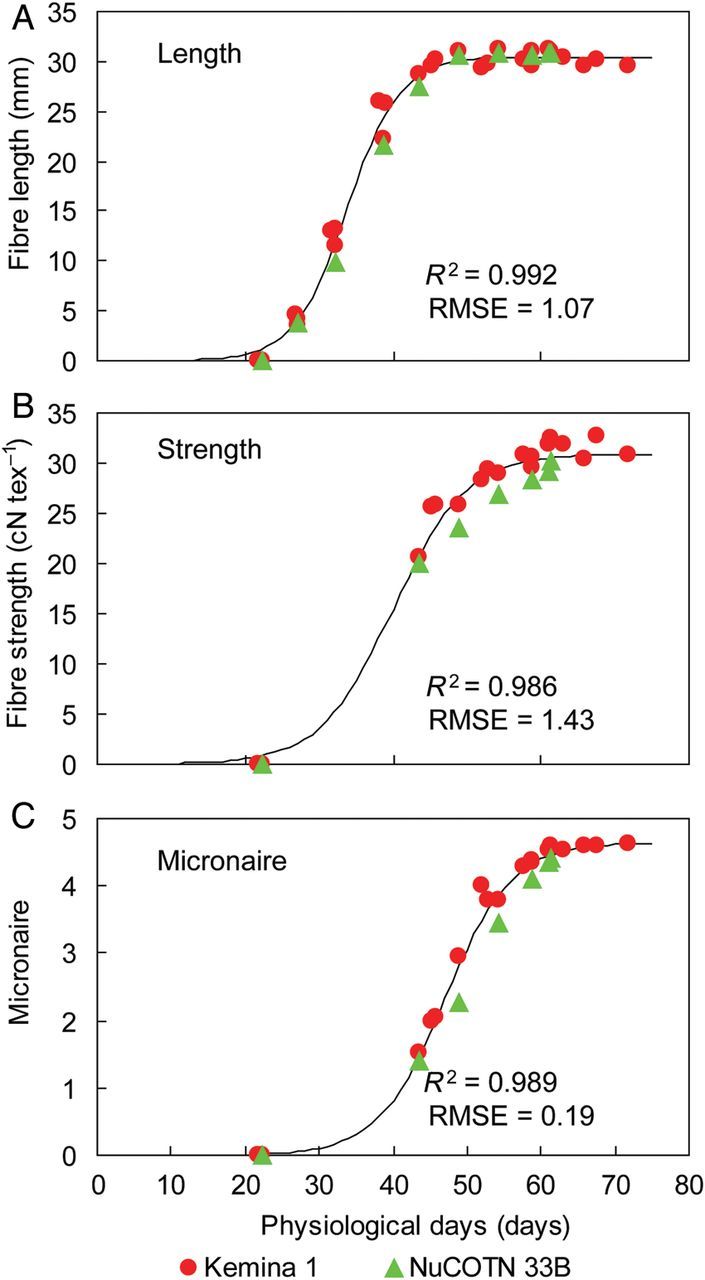
Calibration of potential fibre length (A), strength (B), micronaire (C) against fruit age (days after squaring) in cotton in Anyang in 2007. Symbols of different shape and colour indicate different cultivars.